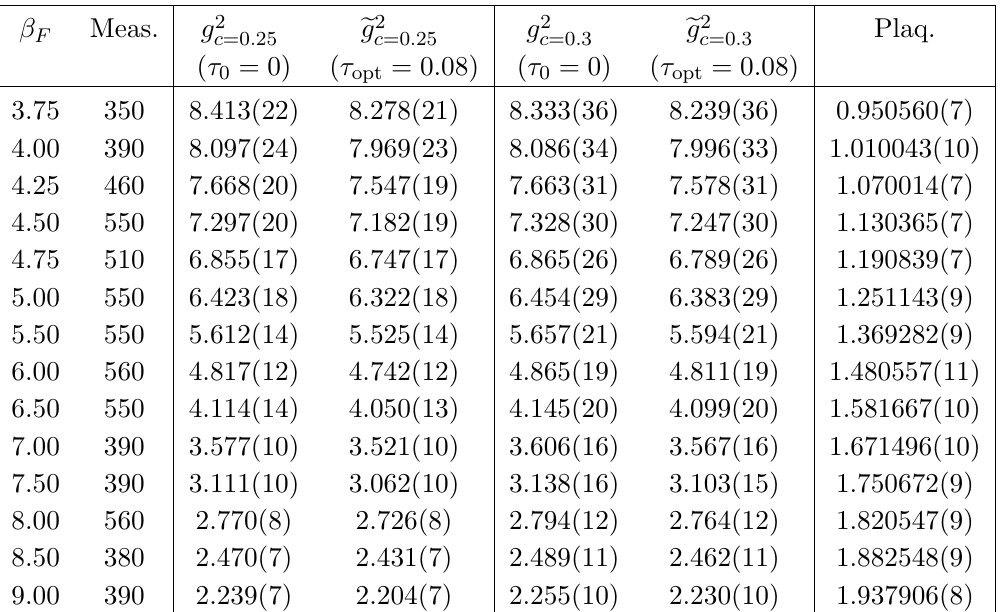
Table 10 . 36 4 lattice ensembles used in this work, with columns as in table